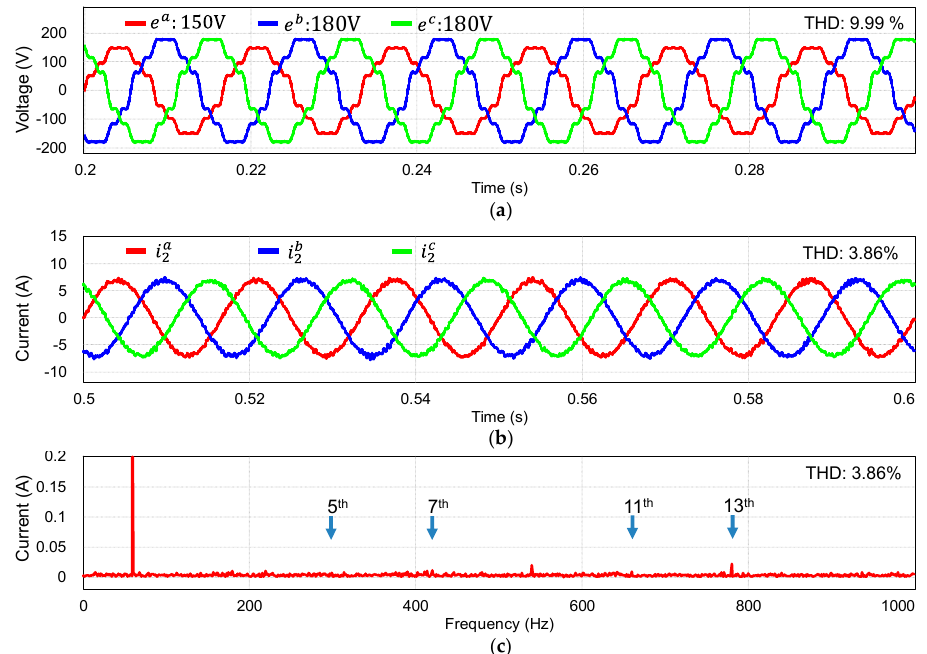
Figure 8. Simulation results of the proposed controller under three-phase distorted and imbalanced grid voltages with e a drop to 83.33% of the nominal value. ( a ) Three-phase grid voltages; ( b ) three- phase grid currents; and ( c ) FFT result of phase- a current.